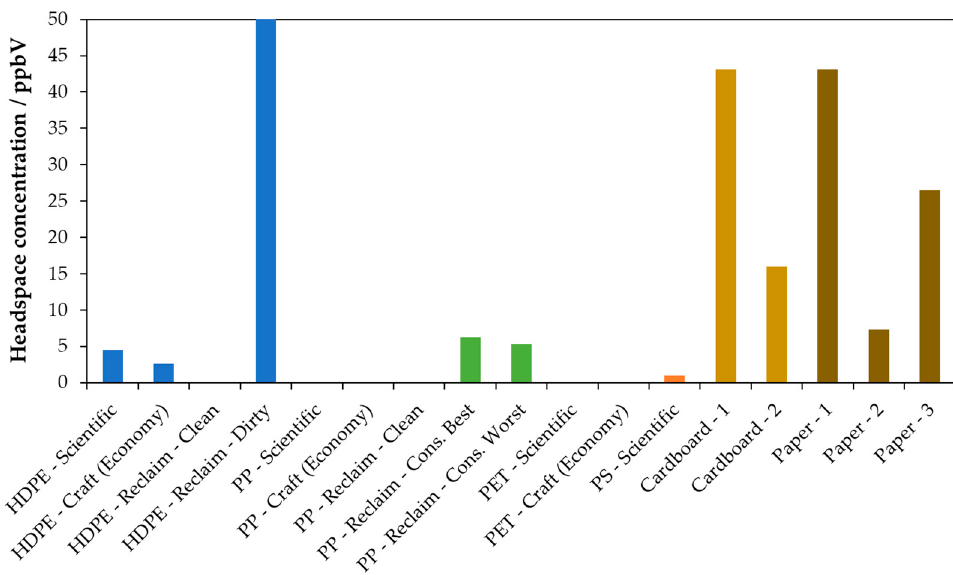
Figure 7. Benzene headspace concentrations (in ppbV) determined using automated SIFT-MS for various packaging materials. See Ref. [160] for full details. Used with permission of Syft Technolo- gies.